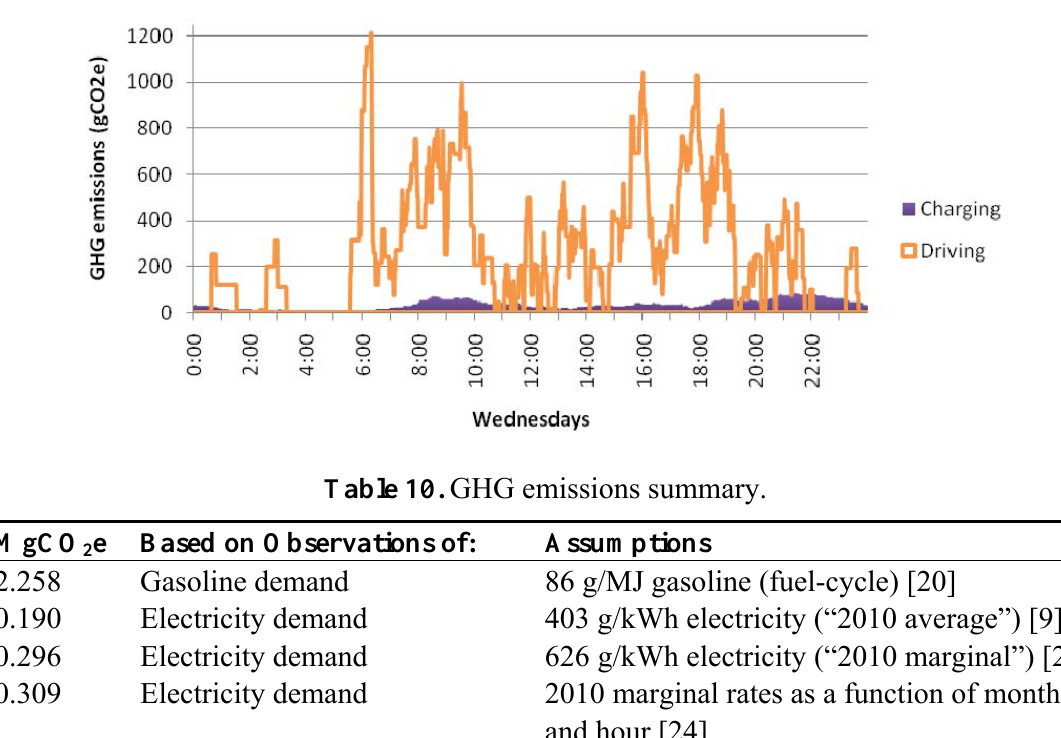
Figure 6. Total GHG emissions by time of day: charging and driving.